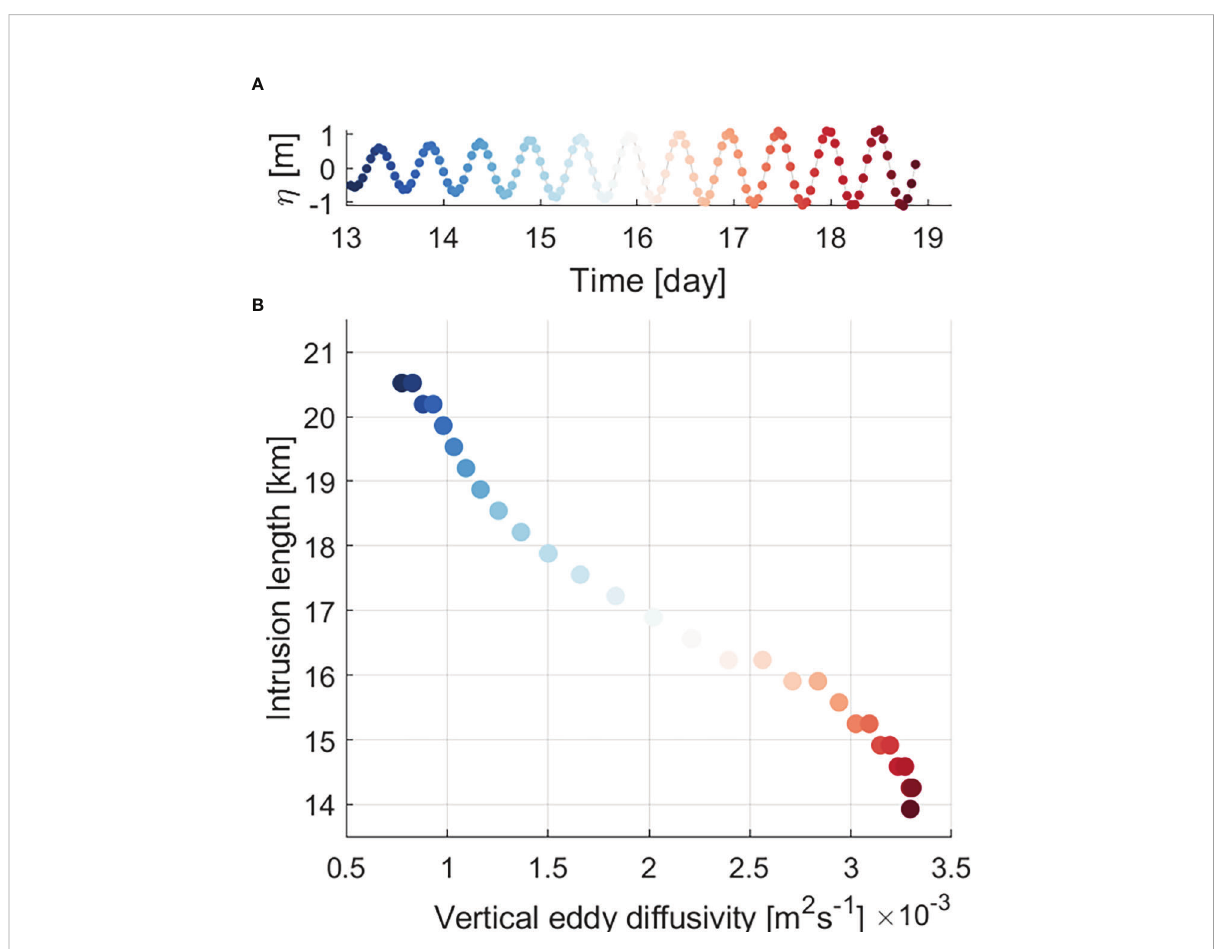
FIGURE 10 (A) Time series of sea-surface height (unit: m) and (B) scatter plot of intrusion length (unit: km) of the 5 gkg -1 isohaline versus cross-sectionally averaged vertical eddy diffusivity K s (unit: m 2 s -1 ) from the model results. Each colored dot in (B) indicates each timing denoted by the same colored dot in (A)